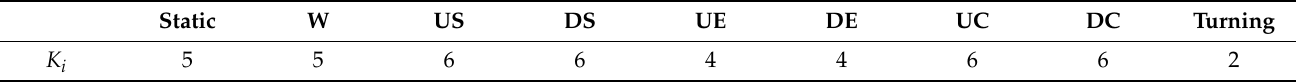
Table 6. Motion mode related feature quantity